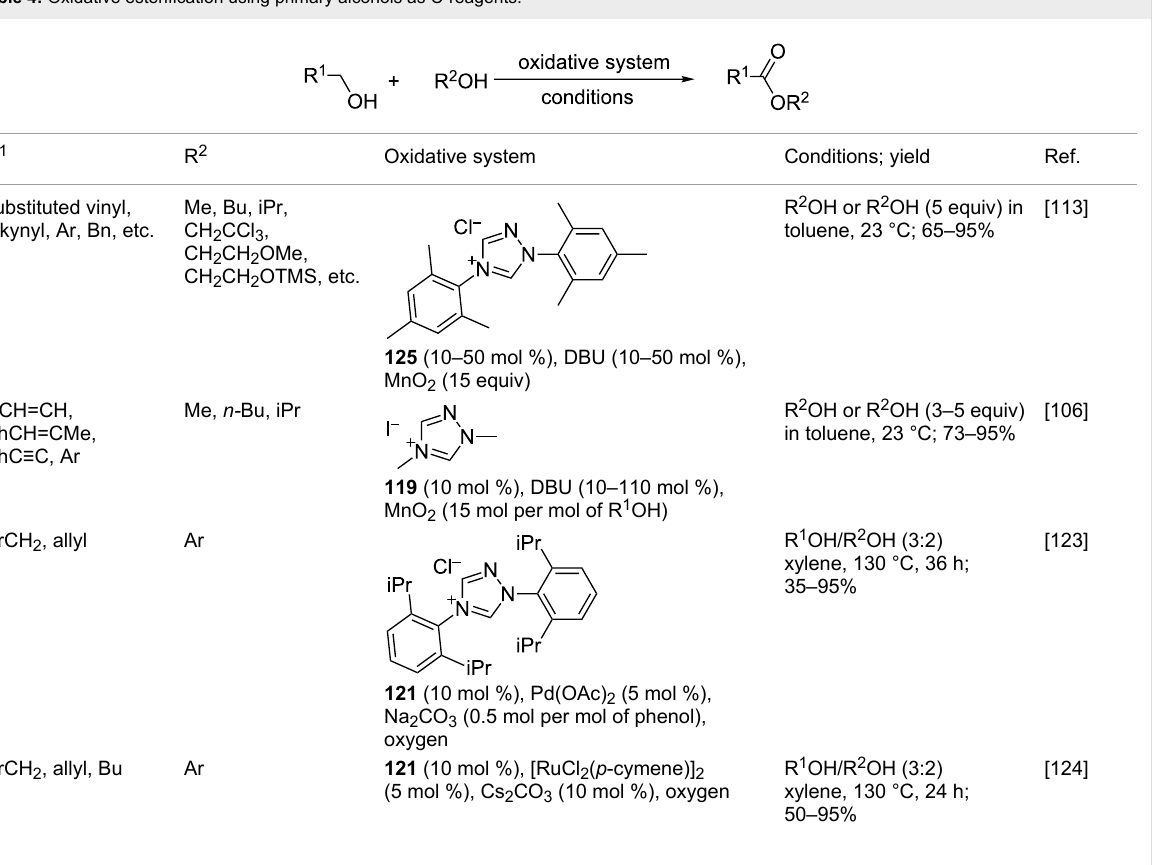
Table 4: Oxidative esterification using primary alcohols as C-reagents.